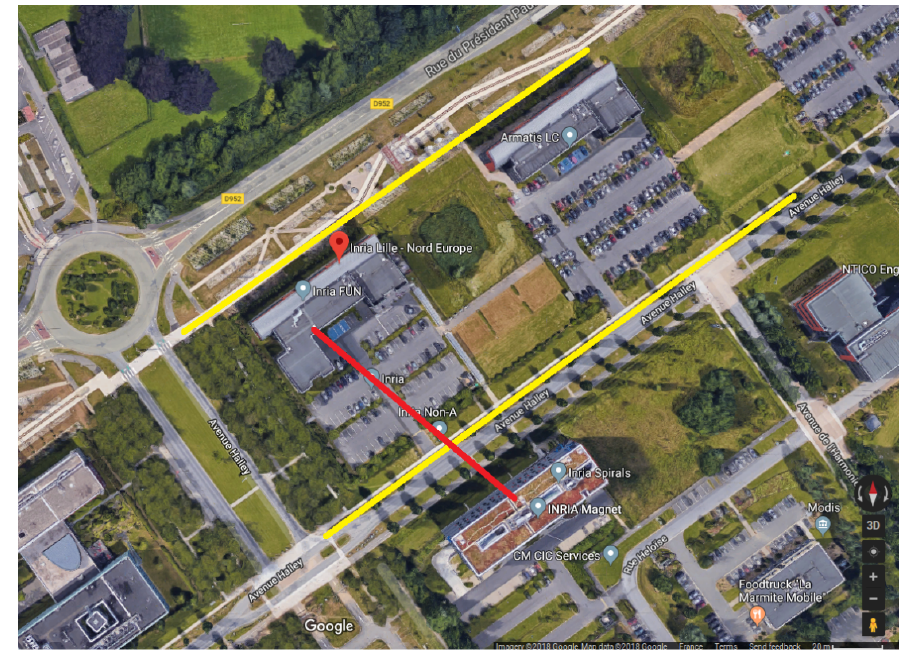
Figure 3. Transmission range testing area. Table 2. Bluetooth and Wi-Fi Direct transmission